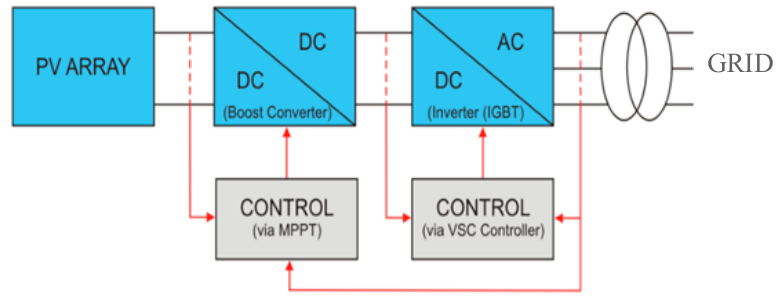
Figure 2. Model of PV-Grid System.